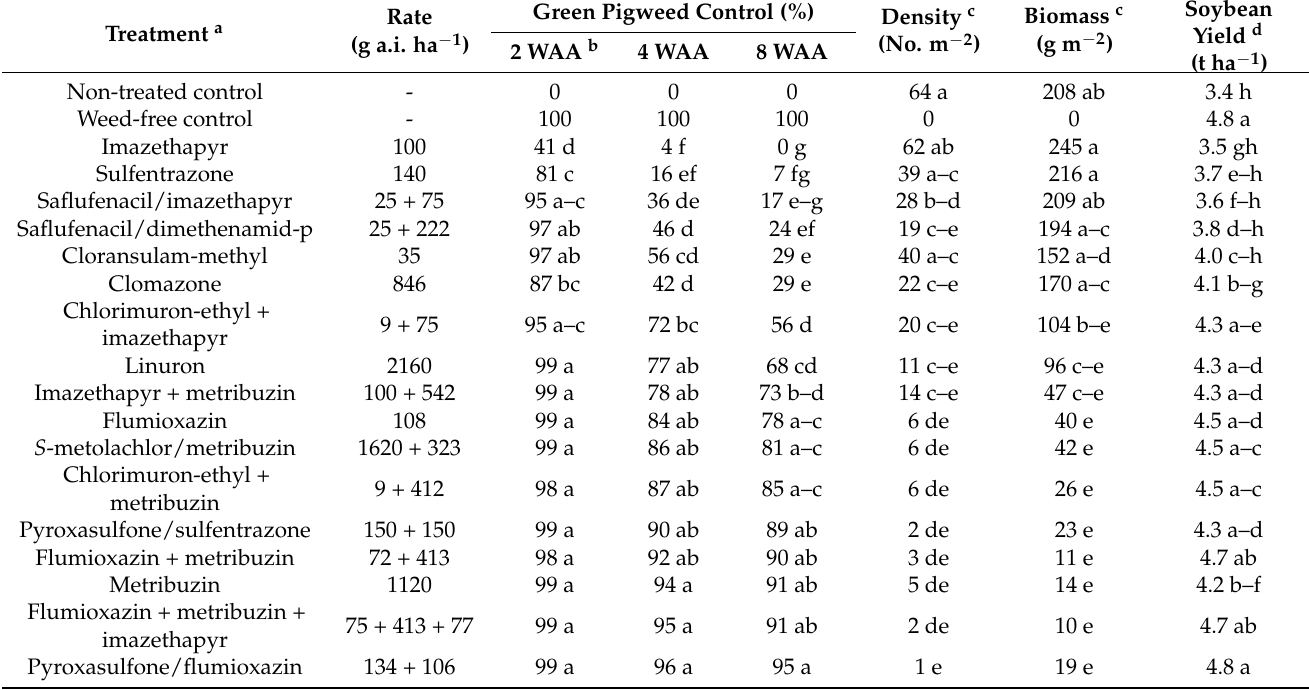
Table 5. Visible green pigweed ( A. powellii ) control, density, biomass, and soybean yield as impacted by PRE herbicide treatments from two field trials conducted in 2019 and 2020 near Dresden,